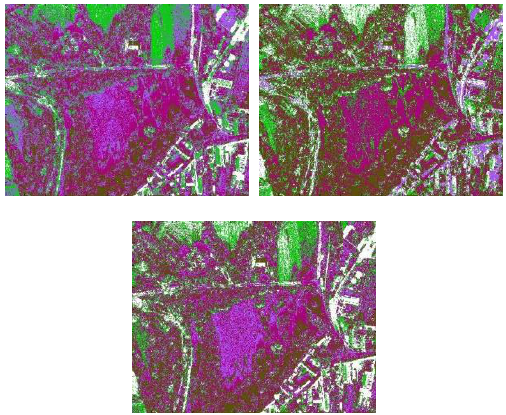
Figure 7: Reclassification of reconstructed image with Cholesky method. In order ML, KM, SOM classifier